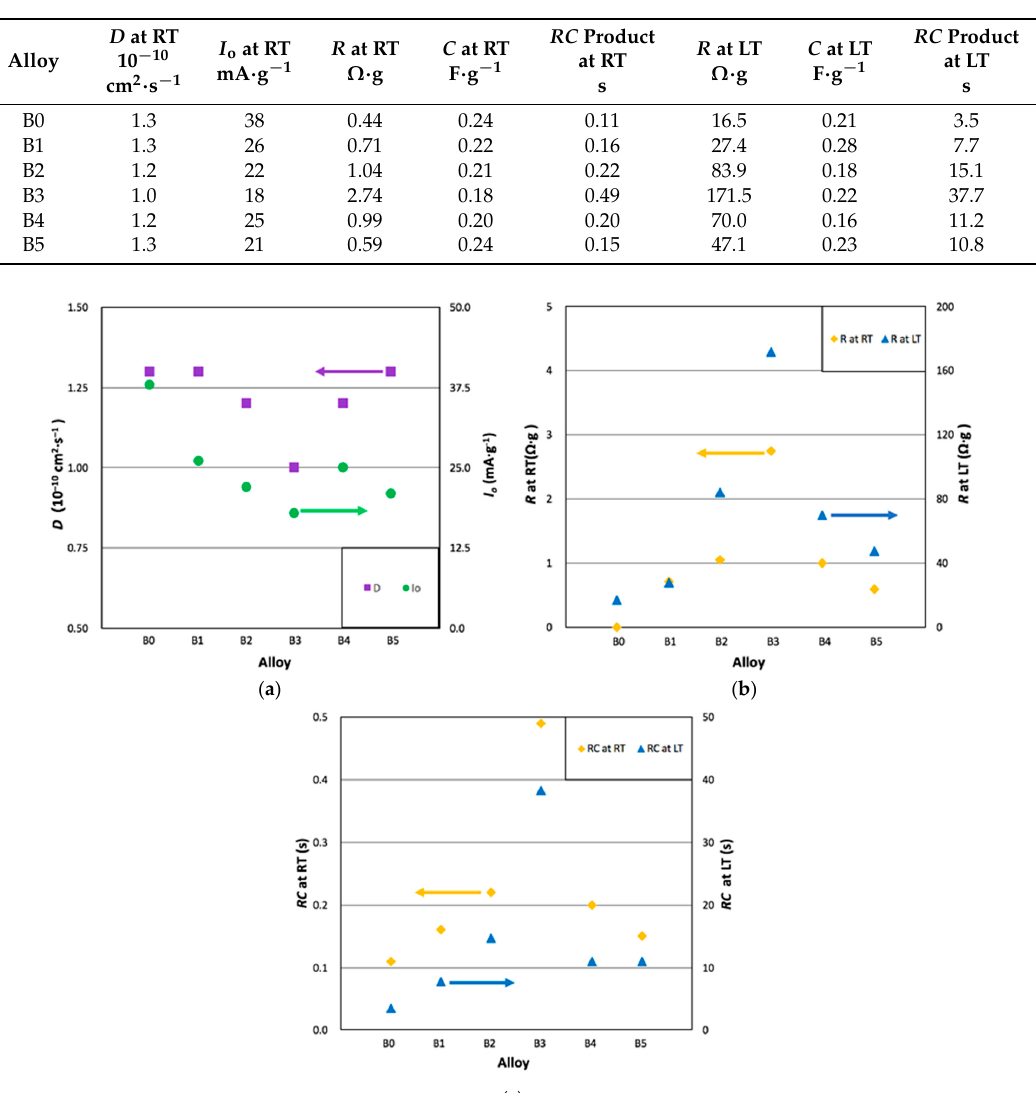
Table 6. Summary of the room temperature (RT) and low temperature (LT) electrochemical properties ( D : bulk diffusion coefficient, I o : surface exchange current, R : charge-transfer resistance, C : double-layer capacitance, and RC product).